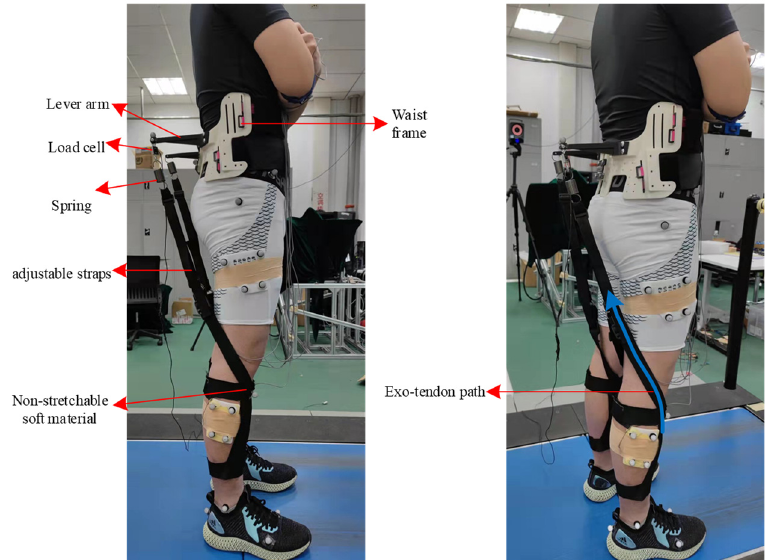
Figure 3. The design of multiarticular unpowered exoskeleton. The waist frame and shank frame were not connected with rigid links and joints to avoid misalignment between human joints and exoskeleton joints.